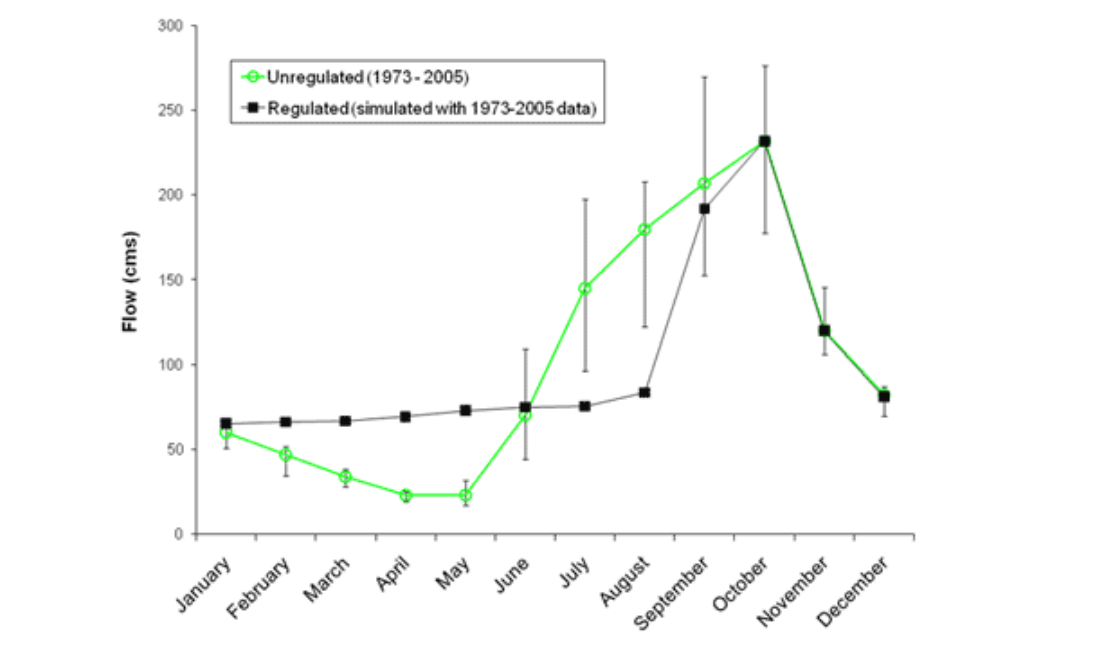
Fig. 5. Comparison of the median monthly flow values for the unregulated flow regime (green; error bars bracket the middle third of the distribution) and the regulated (simulated) flow regime (black) at Cayetano. The IHA analysis indicated that the greatest hydrological alterations will be elevated low flows during the dry season, and a decline in high-flow pulses during the early part of the wet season when the reservoir is filling to